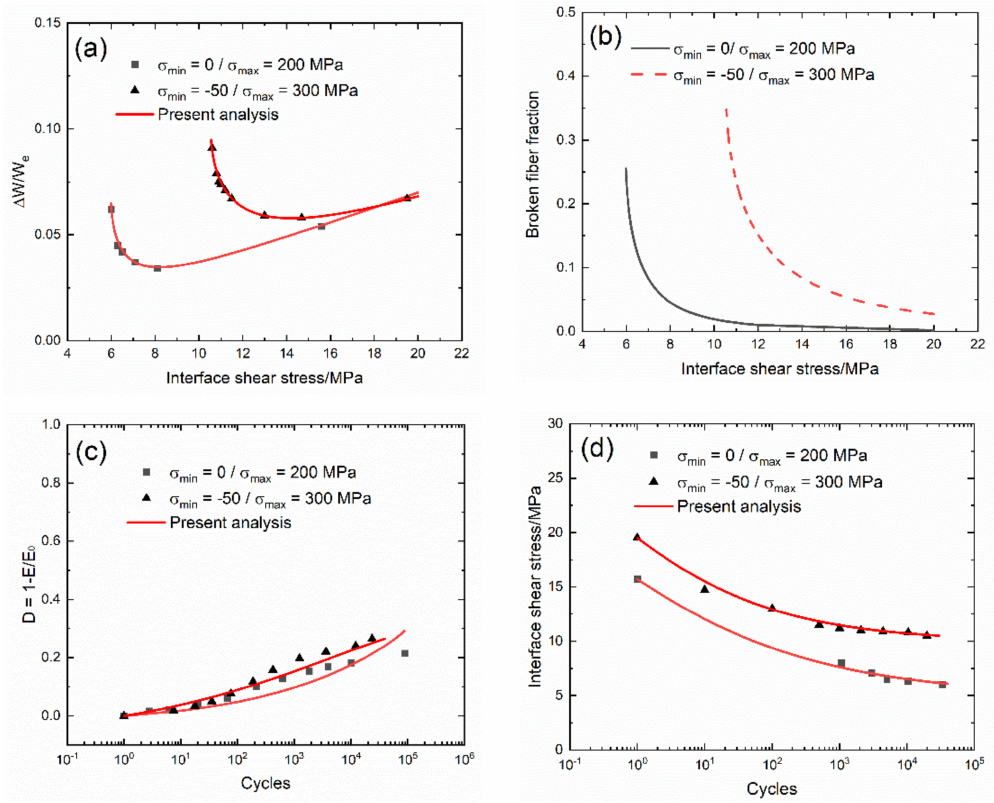
Figure 4. ( a ) Experimental and predicted internal friction parameter ( ∆ W / W e ) versus the interface shear stress curves: ( b ) the broken fiber fraction (P) versus the interface shear stress curves; ( c ) the experimental and predicted Kachanov’s damage parameter (D) versus cycle number curves; and ( d ) the interface shear stress ( τ i (N)) versus cycle number curve of 2.5D woven self-healing Hi-Nicalon TM SiC / [Si-B-C] composite at 600 ◦ C in an air